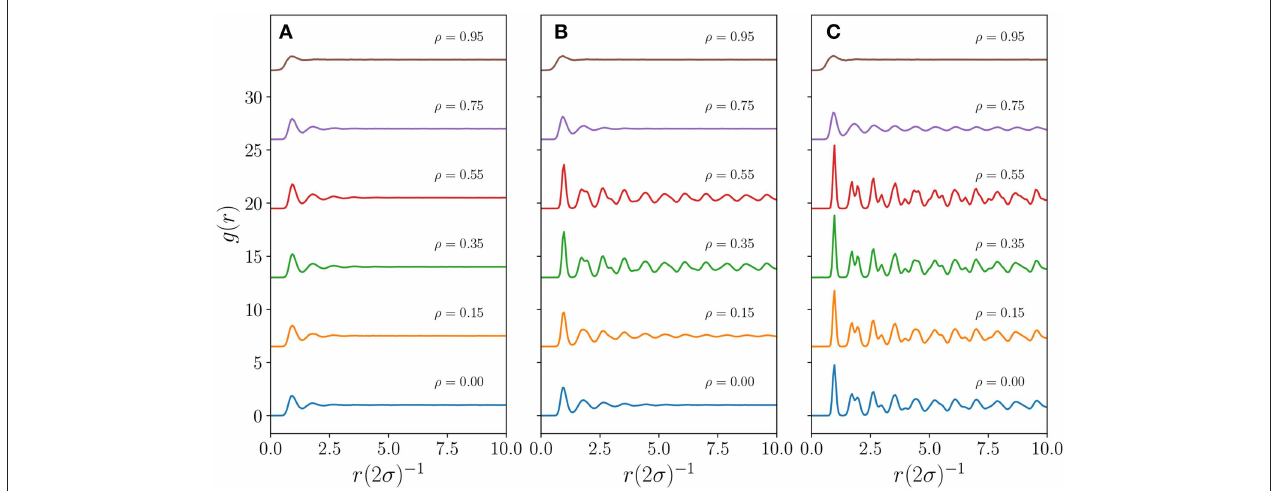
1,200, ν 48. Moving from panel (A–C) , the T A values are 712, 1,068, and 1,424, respectively. = = 0 we have used the results from a previous study = 0; they are 707, 1,070, and 1,409 for panels (A–C) , respectively. These 6=